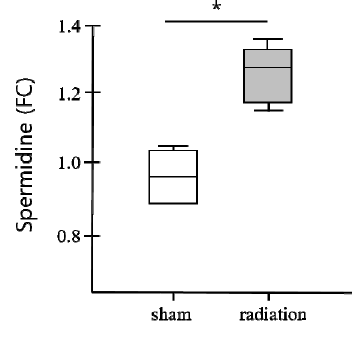
Figure 4. Changes in spermidine biomarker in response to gamma radiation of 6 Gy. p value was calculated by using one-way analysis of variance (ANOVA). * Difference with a p < 0.05 was considered as significant. Abbreviation: FC, fold change [42].